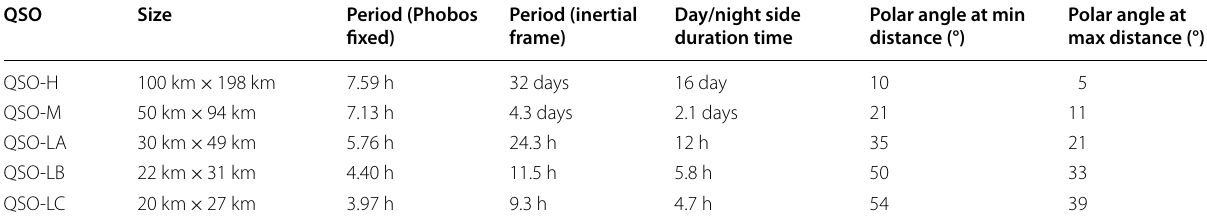
Table 1 QSO characteristics